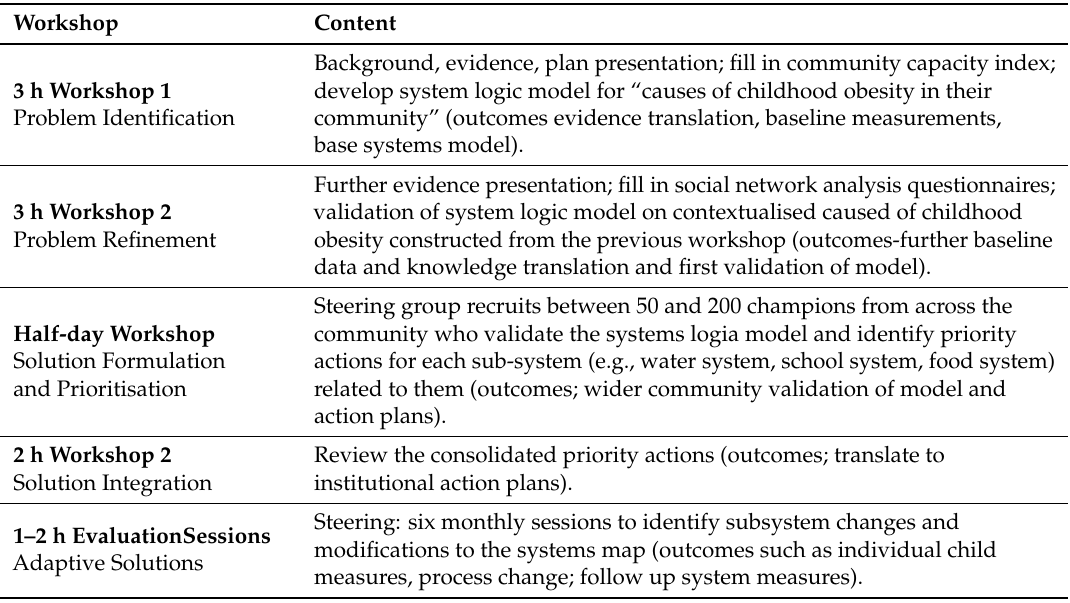
Table 2. Intervention design